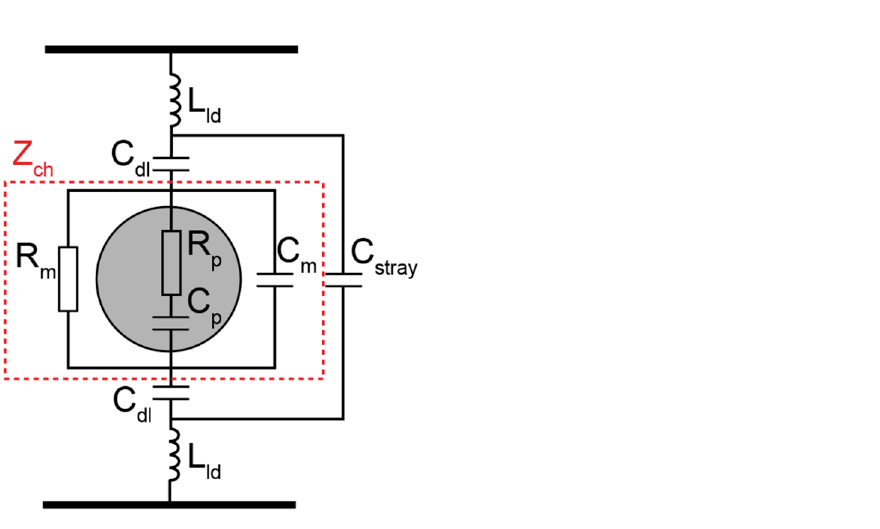
Figure 3. An equivalent circuit model for the impedance measurement system. Channel impedance Z ch was calculated based on Maxwell’s mixture theory